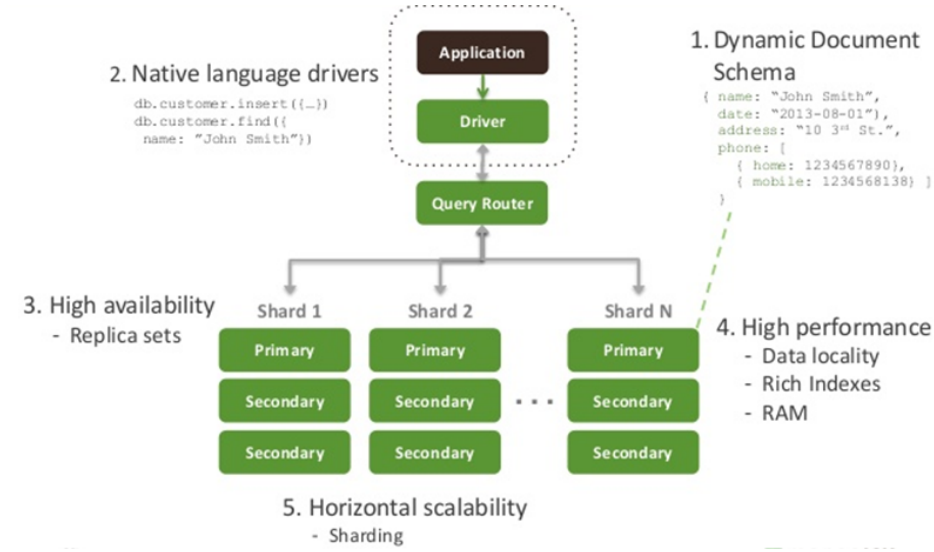
Figure 2. MongoDB Architecture